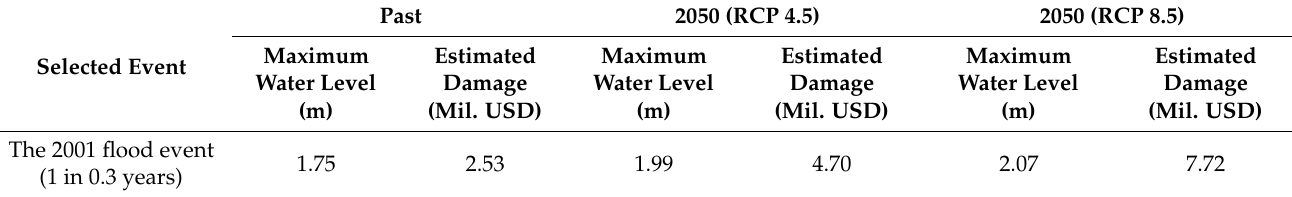
Table 1. The maximum water level in Can Tho and estimated damage in the Ninh Kieu district for historical flood events in 2001 (1 in 0.3 years) and flood events of same return period reoccurring in 2050 based on user-defined inputs under RCP 4.5 climate scenarios and RCP 8.5.